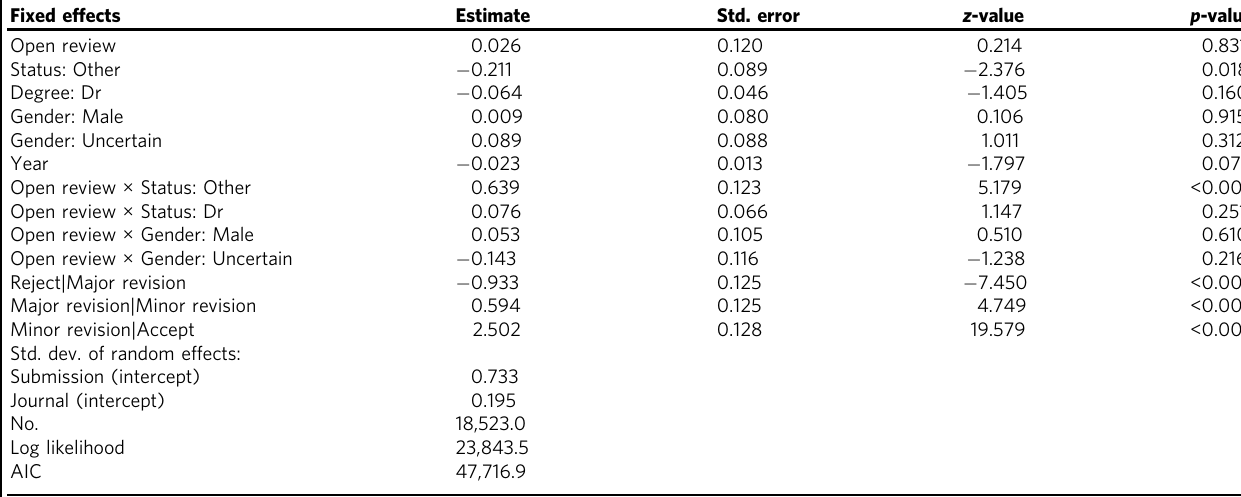
Table 2 Mixed-effects cumulative-link model on referee recommendations Fixed effects